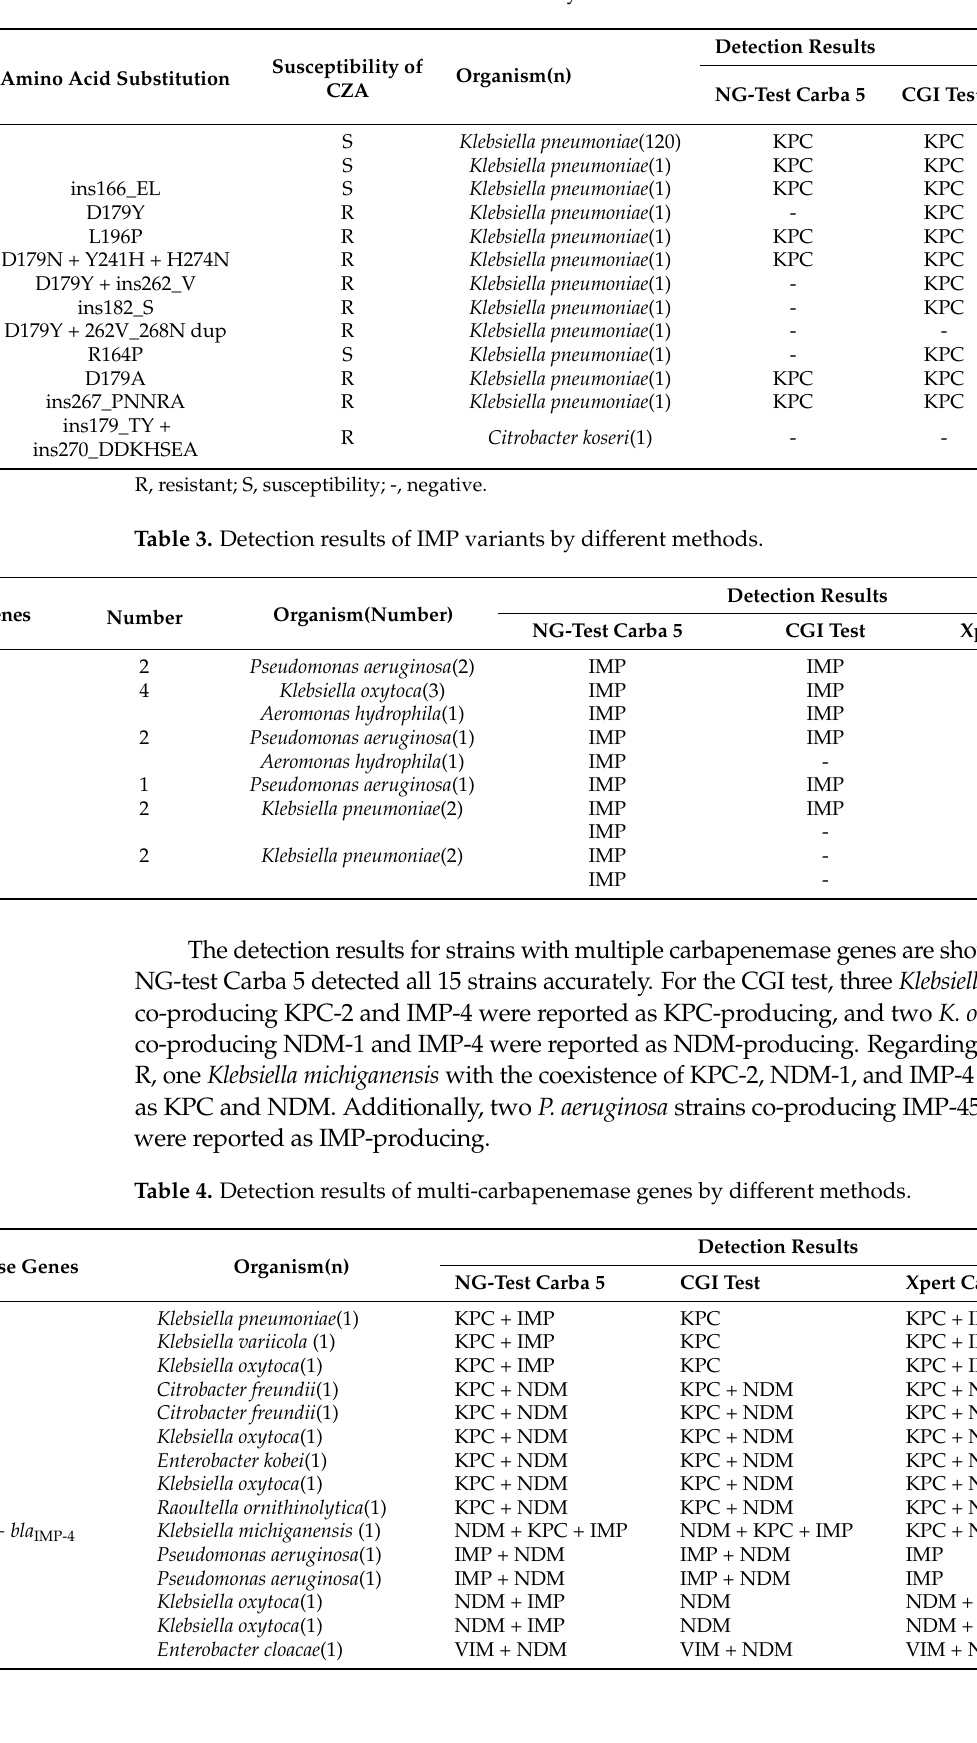
Table 2. Detection results of KPC variants by different methods.